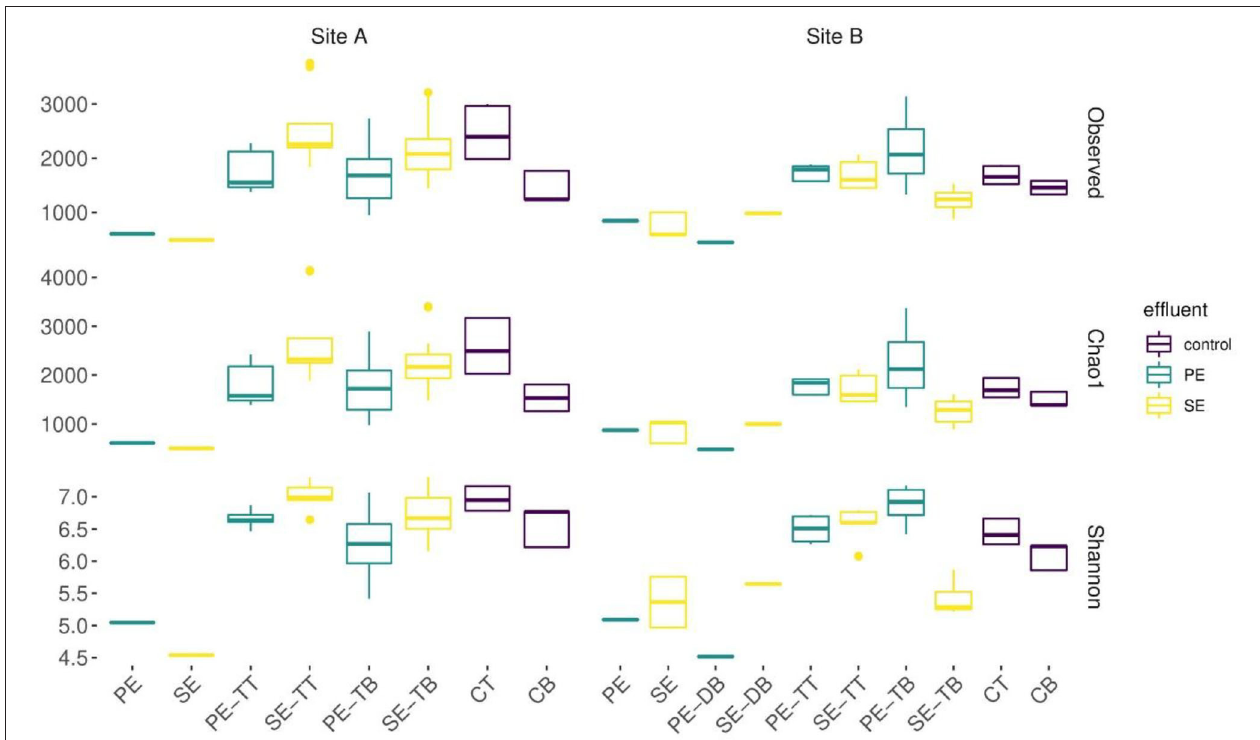
FIGURE 4 | Boxplots displaying rarefied data for the observed OTUs, species richness calculated using an abundance-based coverage estimates (Chao1) and alpha diversity (Shannon). Samples were aggregated on the basis of systems’ primary, secondary effluent (PE, SE), distribution box biofilms (DB), STU top (TT), STU base (TB), control top (CT), and base (CB).